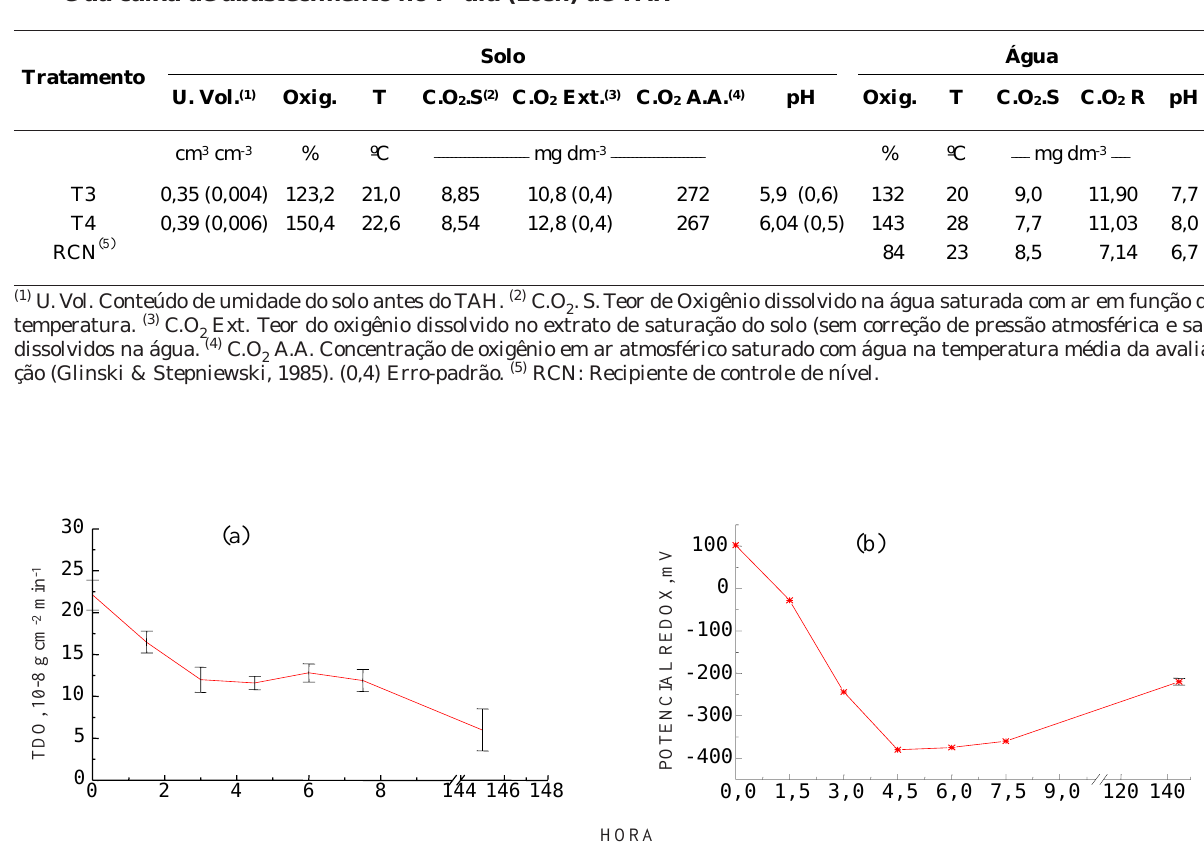
Figura 6. Variação da taxa de difusão de oxigênio (TDO) (a) e variação do potencial redox durante a elevação do lençol